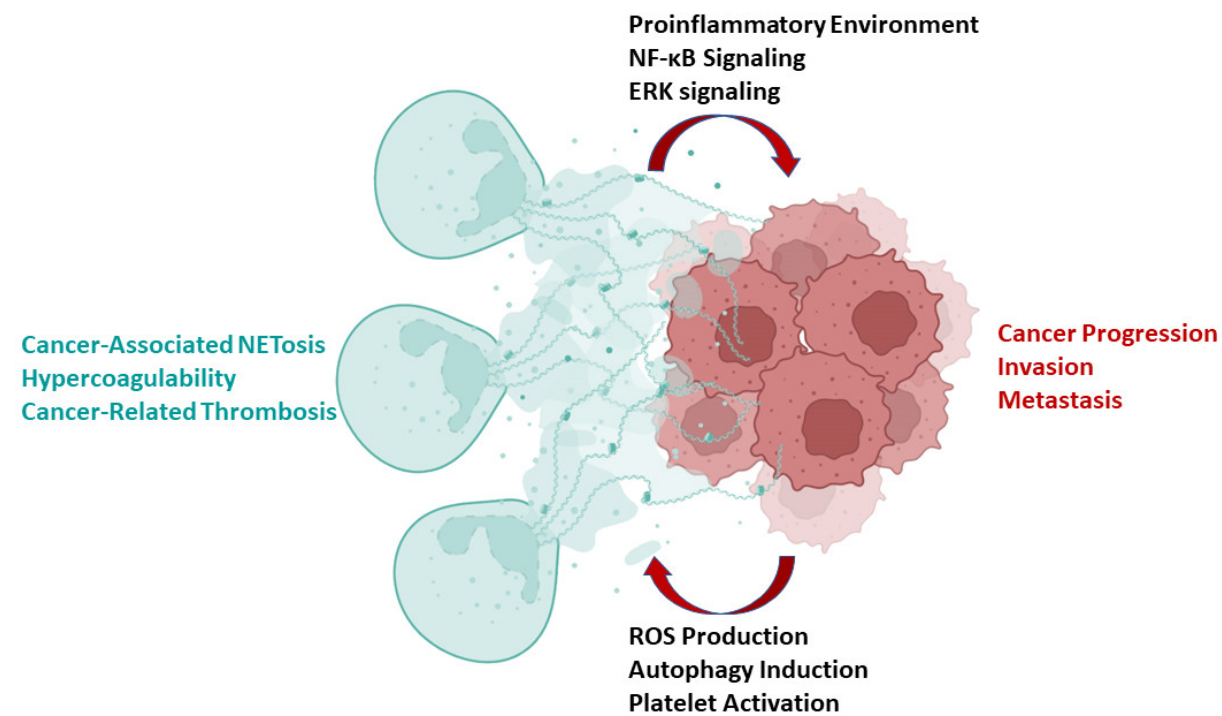
Figure 1. The vicious cycle between NET formation and cancer progression in PDAC. Activated neutrophils (green cells on the left) form NETs, as a result of NETosis. Cancer cells (red cells on the right) grow to form a tumor, partly by interacting with their microenvironment. Each arrow indicates a mechanism that results in NET formation or cancer progression, respectively. The end results of these mechanisms are also presented with color coding corresponding to each procedure (green for NETosis and red for tumor growth).